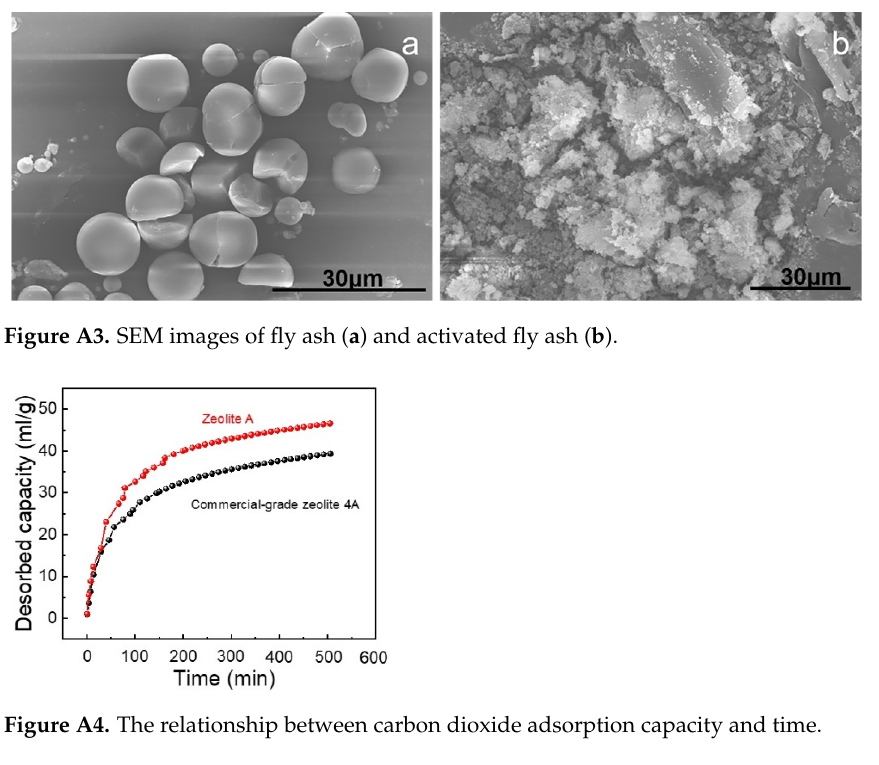
Figure A2. XRD patterns of fly ash ( a ) and activated fly ash ( b ).